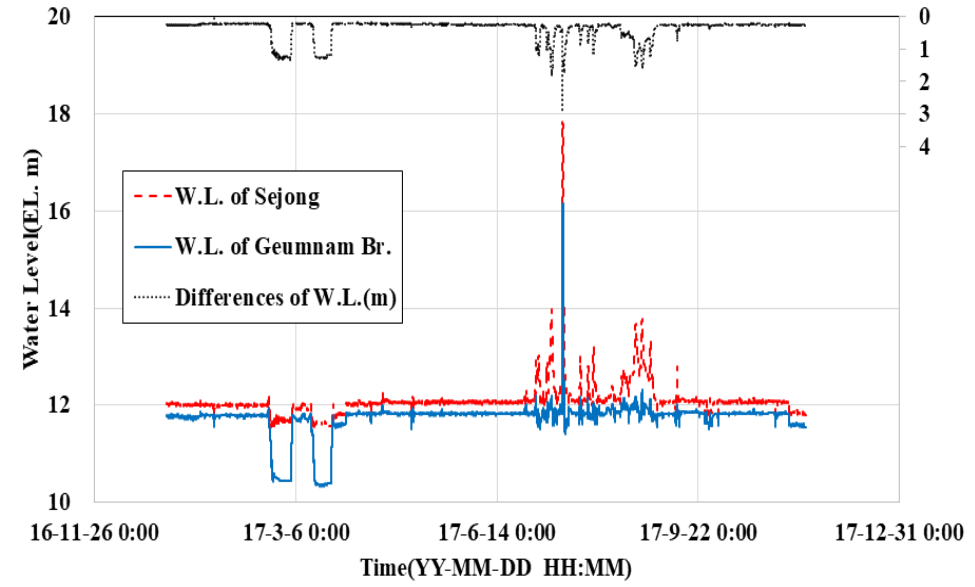
Figure 3. Water levels at Sejong-ri and Geum nam Br. gauging stations and the differences between the values.